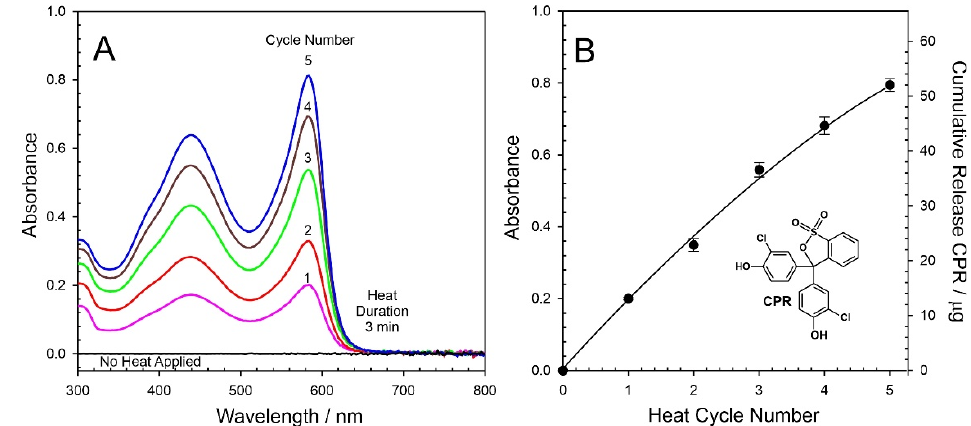
Figure 9. ( A ) UV/Vis spectra detailing the cumulative release of chlorophenol red (CPR) from the wax composite into pH 6 buffer with repetitive heat cycles (heat duration of each cycle: 3 min; cooling period: 10 min). ( B ) Estimation of CPR released.